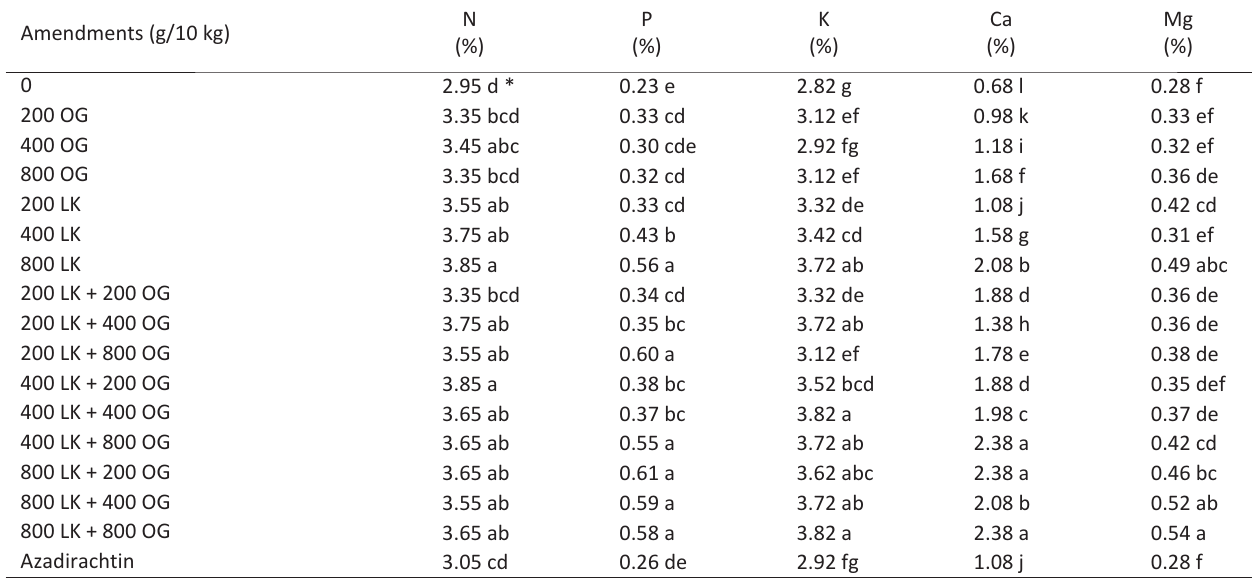
Table 3 ­ Effect of fresh plant organic amendments on tissue analysis of greenhouse